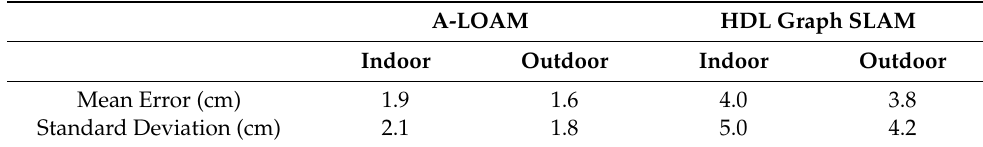
Table 3. Accuracies of the